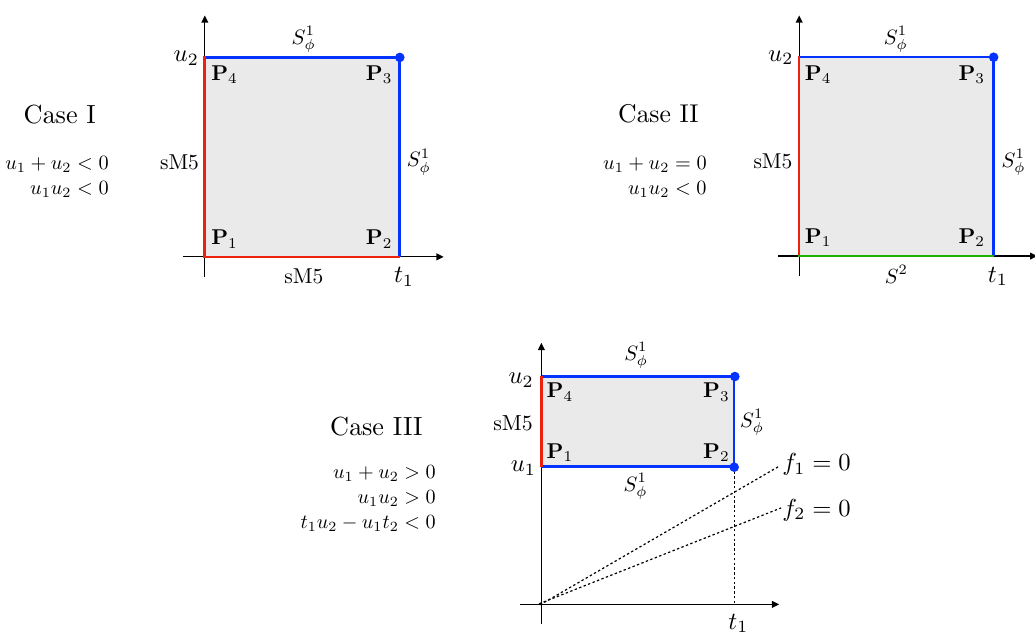
and u . The label S 1 indicates that 1 ≤ t 2 1 < u 2 φ